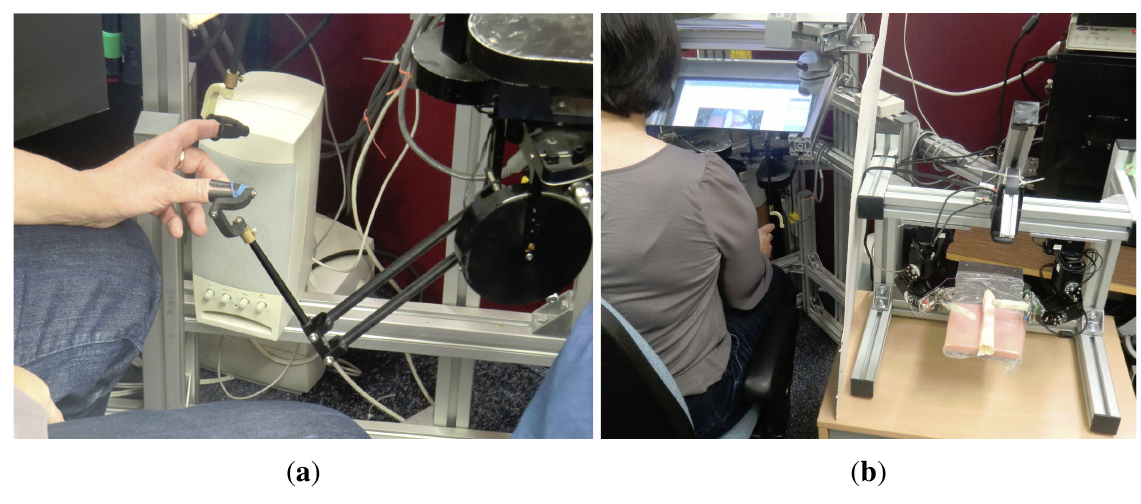
Figure 4. The virtual prototyping system for the evaluation of the sensor configurations of a surgical instrument. ( a ) Detail of the master multi-finger haptic workstation; ( b ) the master and the slave